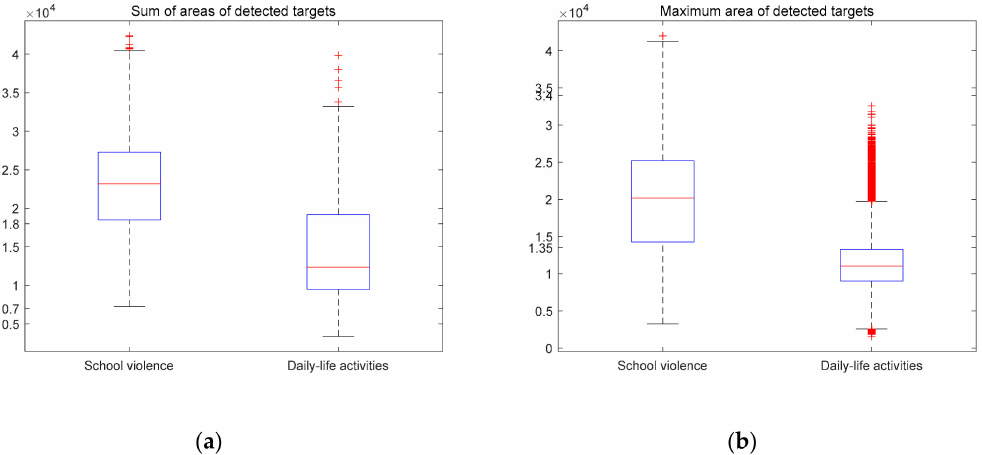
Figure 9. Two examples of boxplots: ( a ) the sum of the areas of the detected targets and ( b ) the maximum areas of the detected